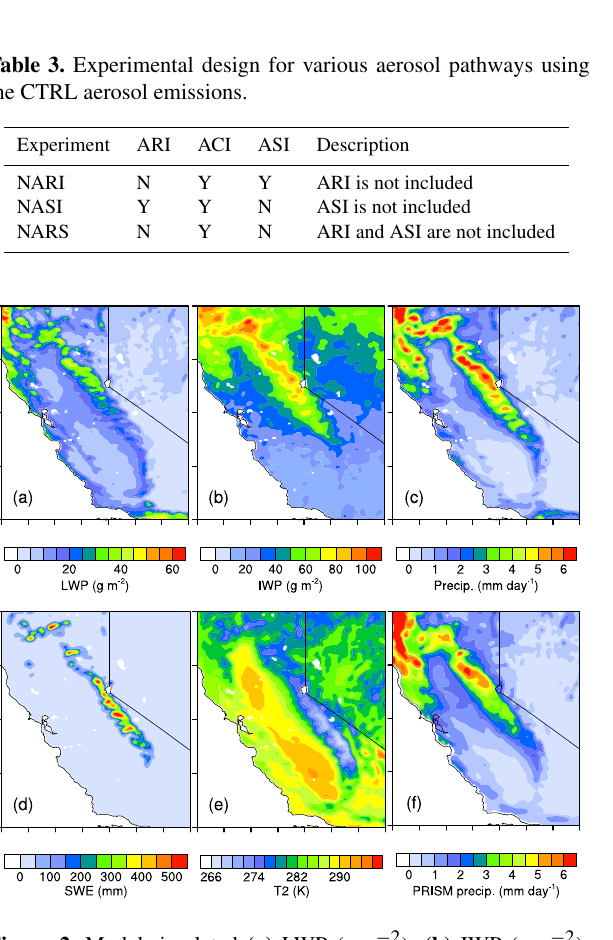
Figure 2. Model-simulated (a) LWP (gm − 2 ) , (b) IWP (gm − 2 ) , (c) precipitation (mmday − 1 ) , (d) SWE (mm), and (e) tempera- ture at 2m, T2 (K) from the CTRL simulation, and (f) PRISM ob- served precipitation (mmday − 1 ) , averaged from October 2012 to June 2013.